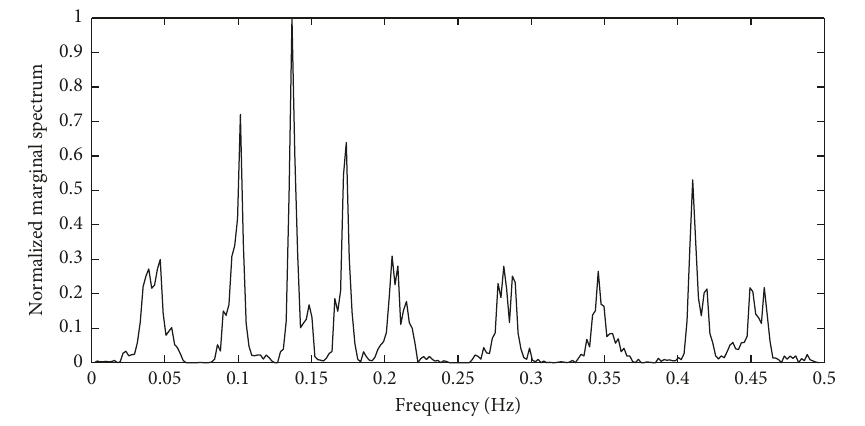
Figure 4: Normalized marginal spectrum of the tree ring. Table 1: Variance contribution rate, correlation coefficient calculation, and sorting condition of IMF components of tree ring width. Component